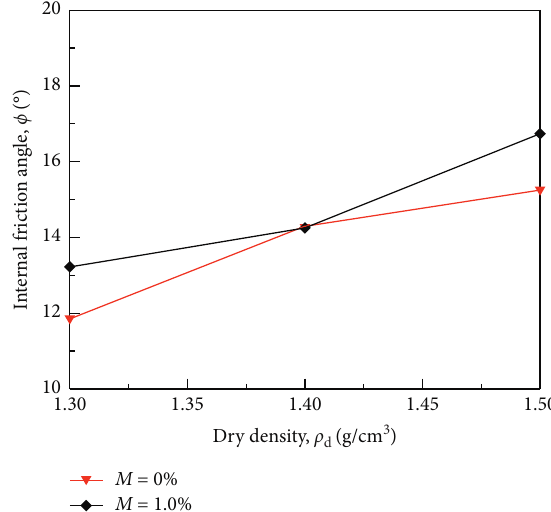
Figure 8: Effect of dry density on cohesion.